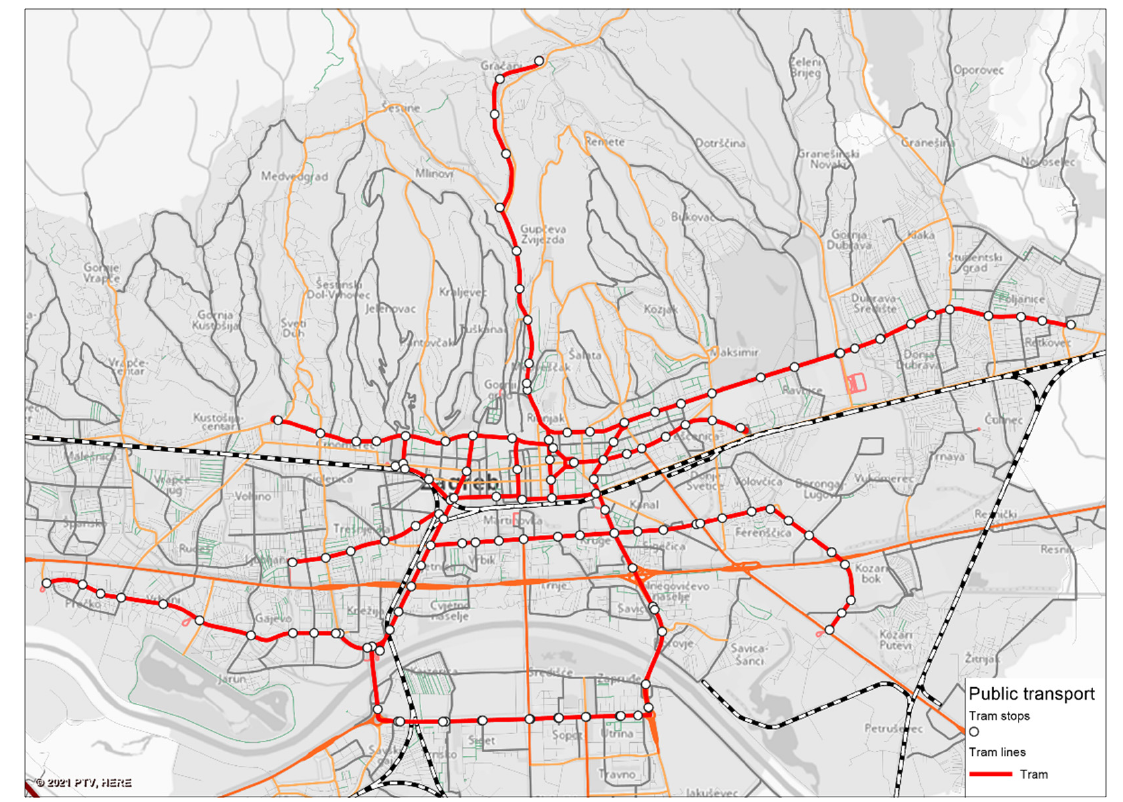
Figure 1. Double-track tram network in the City of Zagreb.